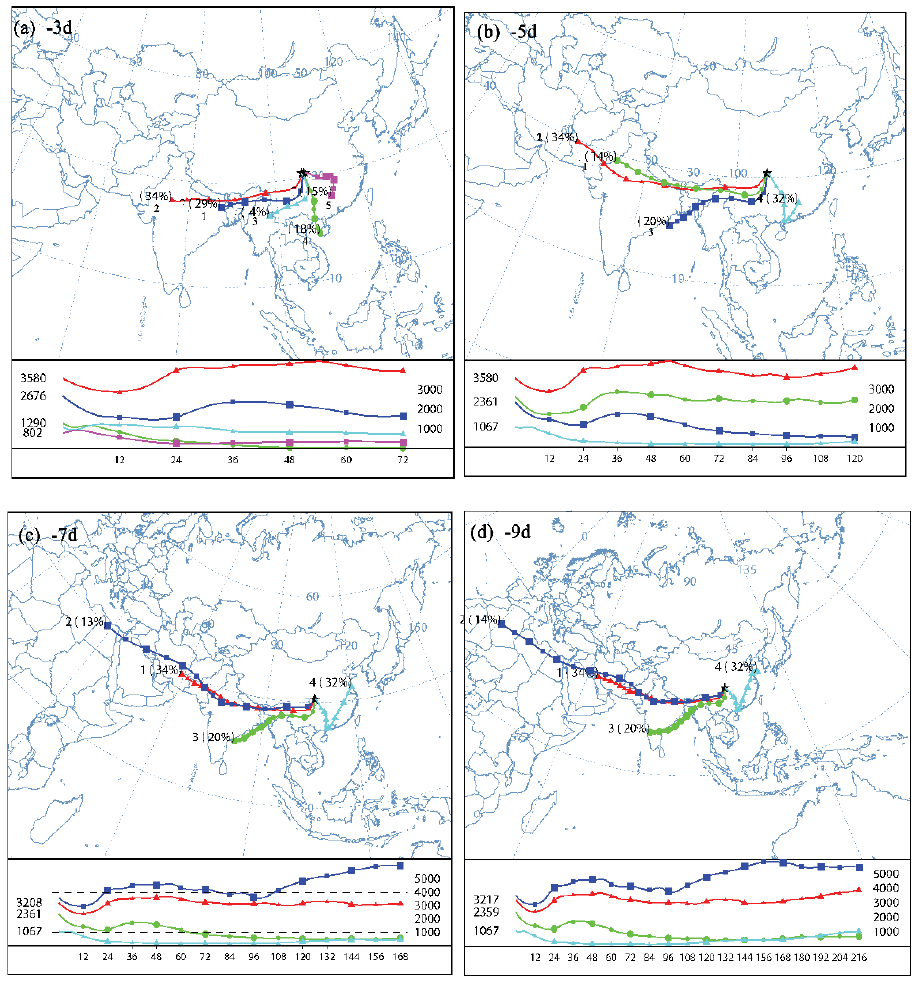
Figure 10. The average trajectory (bold lines) and the corresponding percentage ( a ) on the third day (-3 days), ( b ) 5th day (-5 days), ( c ) 7th day (-7 days), and ( d ) 9th day (-9 days) before reaching the target area. The percentages inside the brackets indicate the fractions of the trajectory number in each path (i.e., the air parcel’s contribution to the target area) in all trajectories. The numbers 1, 2, 3, 4 represent path 1, path 2, path 3 and path 4, respectively.